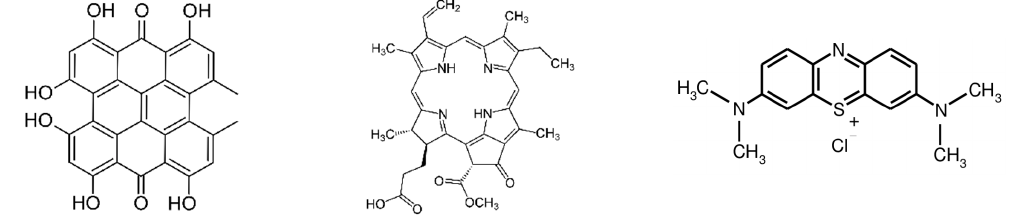
Figure 1. Chemical structures of 3 PSs used in the current investigation .